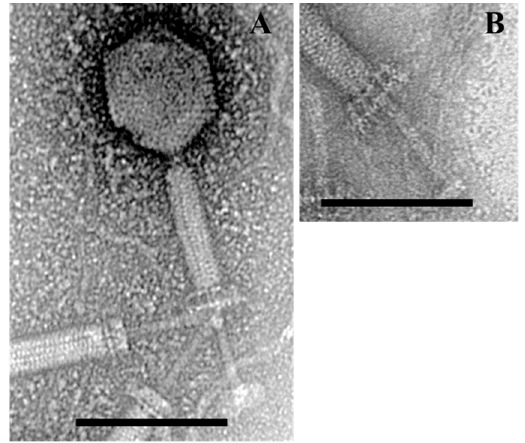
Figure 1. Transmission electron micrographs of Bacillus bacteriophage BSP10. Contracted state of bacteriophage BSP10 ( A ); baseplate structure upon tail contraction ( B ). The scale bar corresponds to 100 nm.